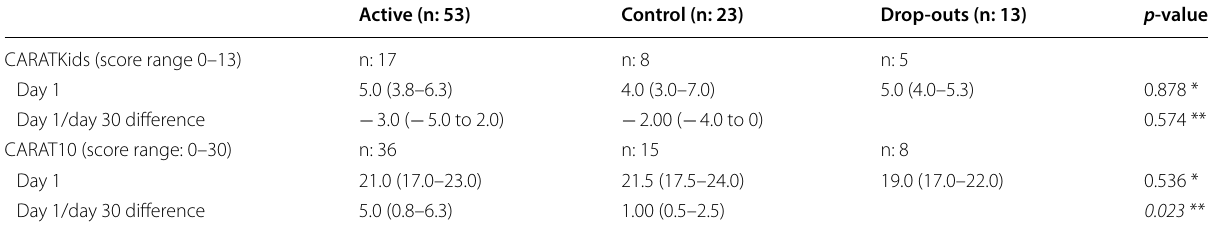
Table 2 CARATKids and CARAT10 scores on day 1, and individual differences between day 1 and day 30: CARAT scores in day 1 did not differ significantly for active, control and drop-outs; by contrast, CARAT10 changes for each patient were significantly different between day 1 and day